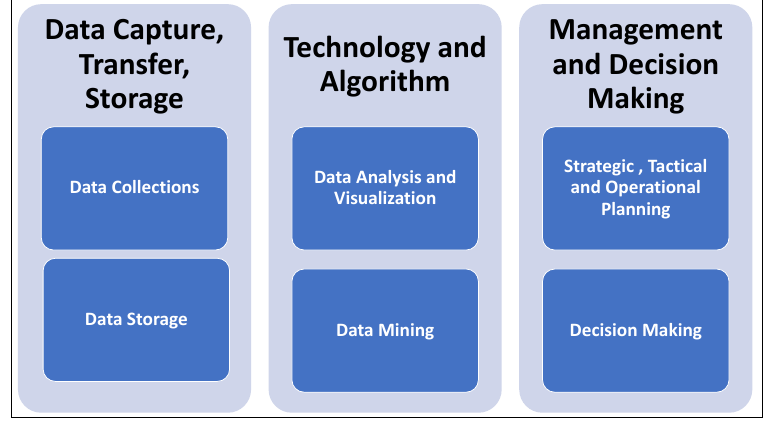
Figure 1. Key components of data analysis